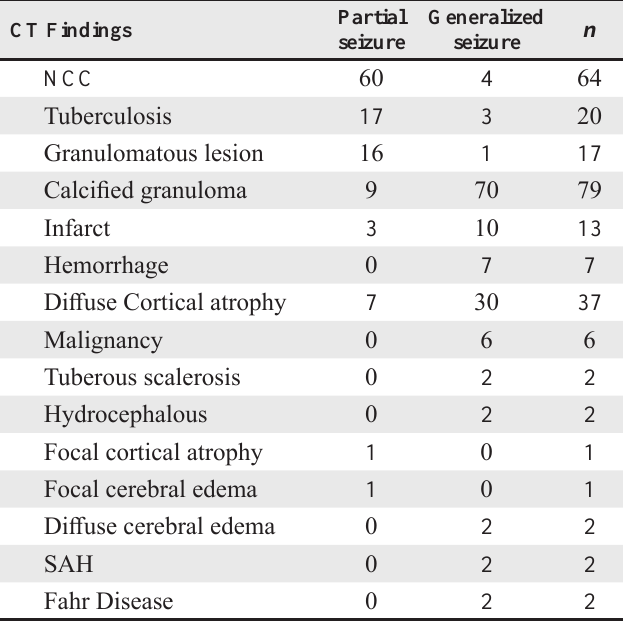
Table 3 : CT scan findings in patients with seizure according to the type of seizure.